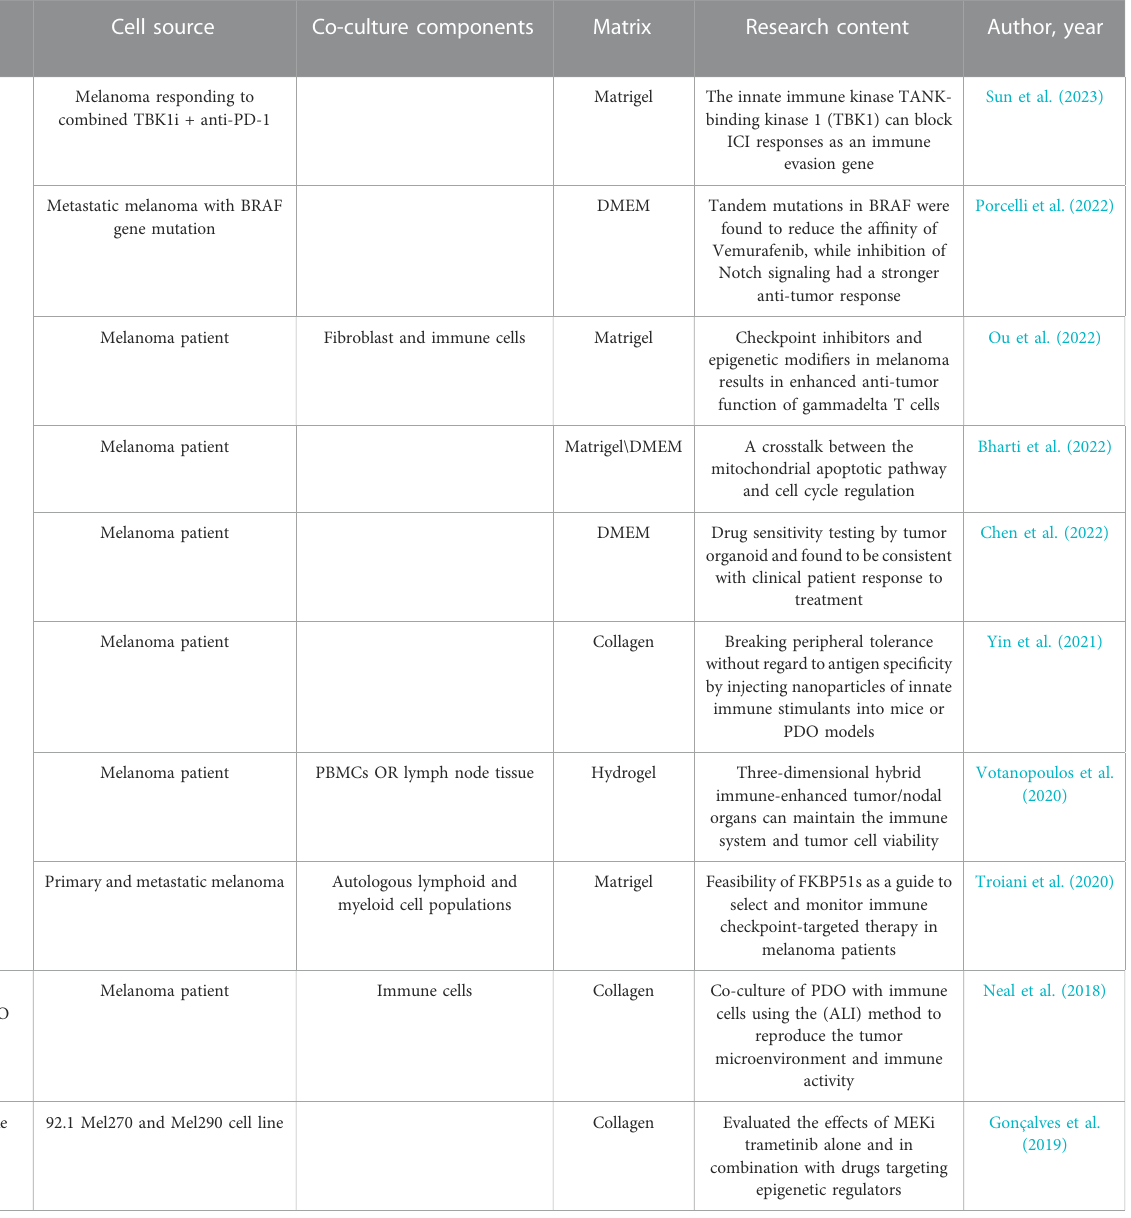
TABLE 1 Summary of organoid applications in multiple